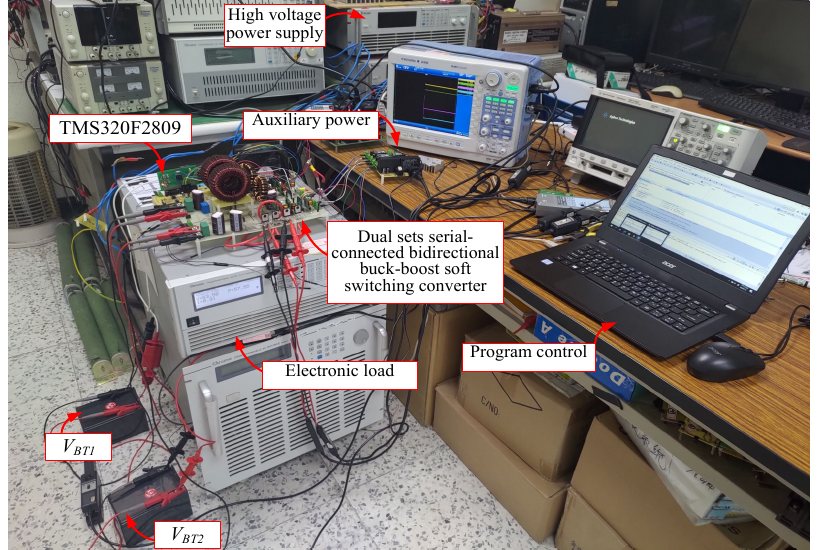
Figure 10. Hardware circuit architecture of battery energy storage system with uniform charge and discharge. Table 4. The different output power rates of the photovoltaic module, the initial voltage of each set of batteries, and the final voltage after reaching uniform charging and discharging state.